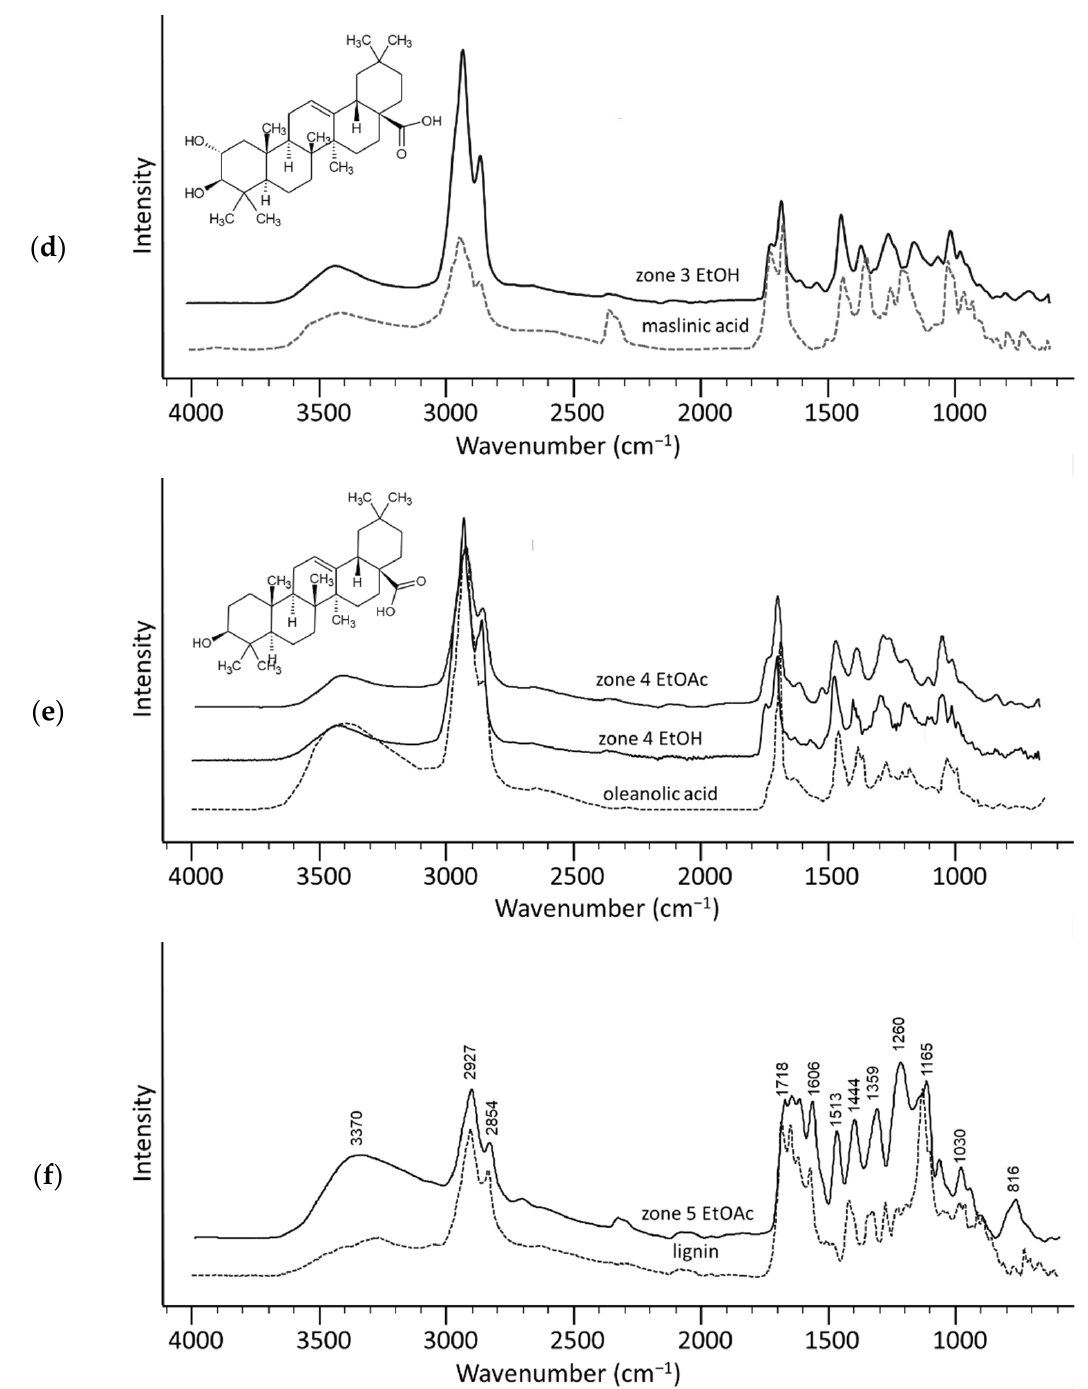
Figure 4. Superimposed ATR-FTIR spectra of isolated zones from the chromatograms of fermented ethanol and ethyl acetate extracts (black lines) superimposed to different reference standards (dashed lines). ( a ) oleuropein and zone 1 from ethyl acetate and ethanol extracts; ( b ) ursolic acid and zone 2 from ethanol extract; ( c ) rosmarinic acid and zones 2 and 3 from ethyl acetate extracts; ( d ) maslinic acid and zone 3 from ethanol extract; ( e ) oleanolic acid and zones 4 from ethanol and ethyl acetate extracts; and ( f ) lignin and zone 5 from ethyl acetate extract.